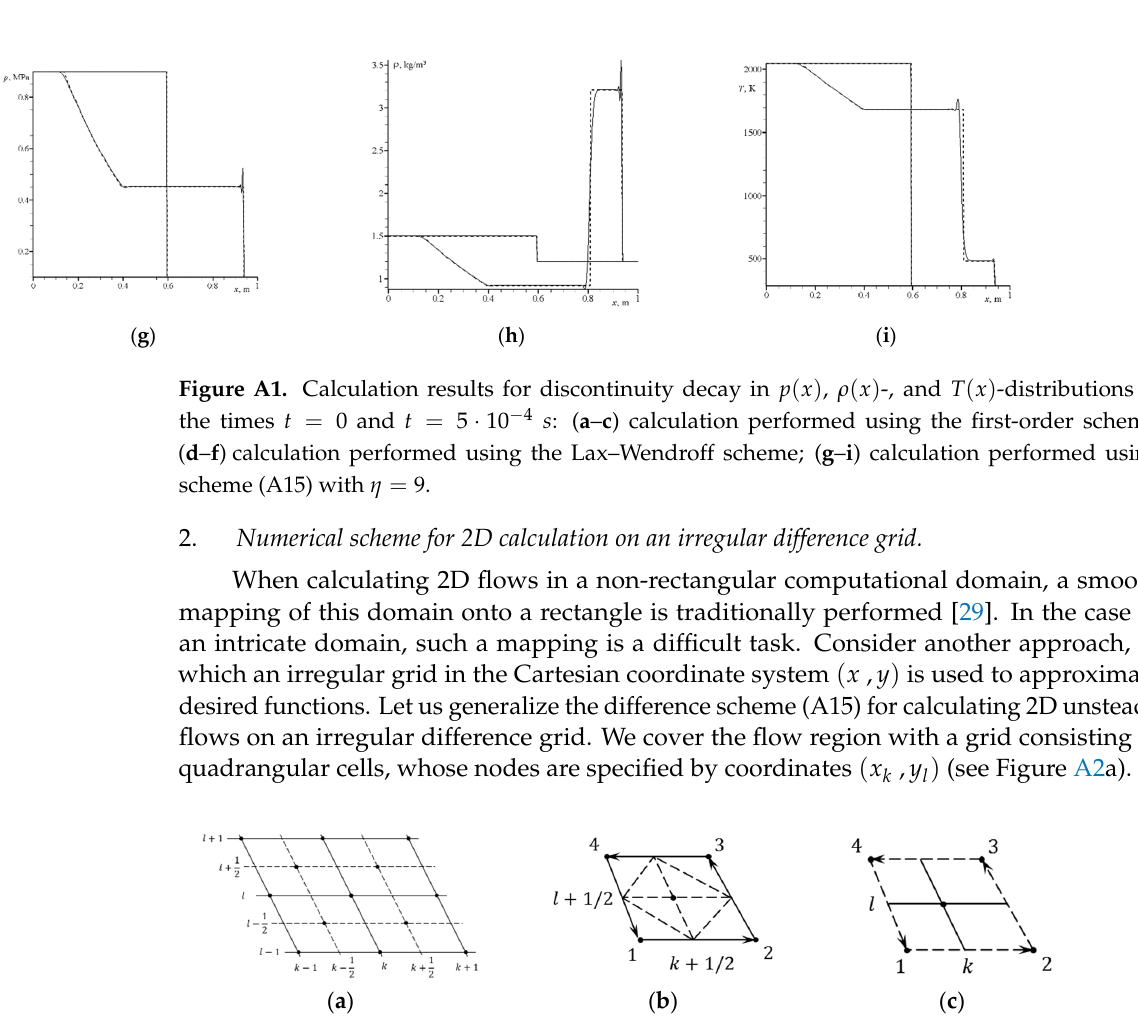
, is shown in Figure A2b. In the same